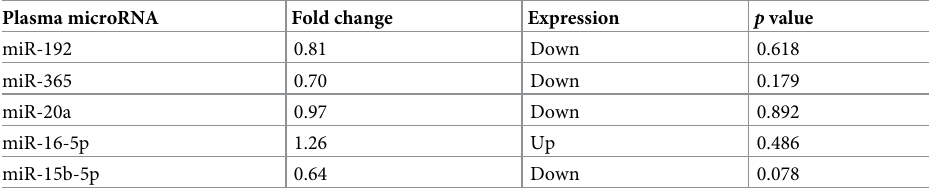
Table 5. Comparison between control and PKD group on miRNA expression ratios from feline